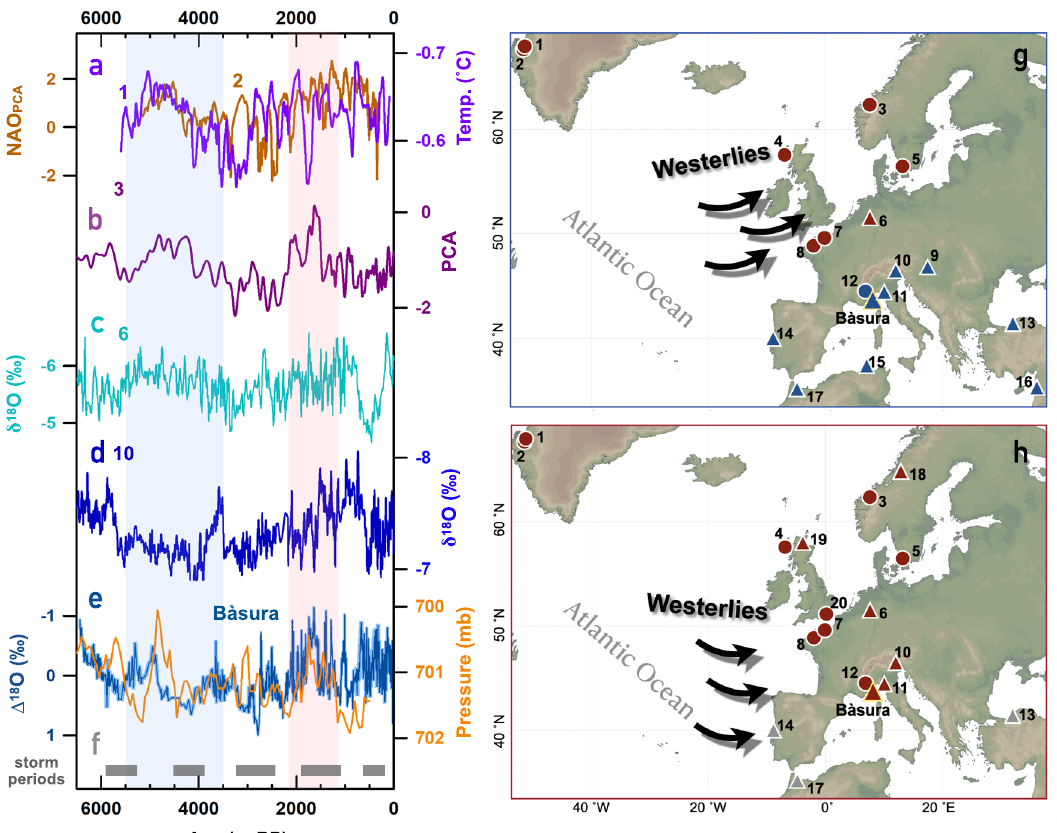
Fig. 2 | Migration of the westerlies. a The reconstructed North Atlantic Oscilla- tion (NAO PCA ) index 40 (brown) and Greenland lake temperature (temp.) reconstructions 43 (purple). Low temperature indicates positive NAO phase 43 .